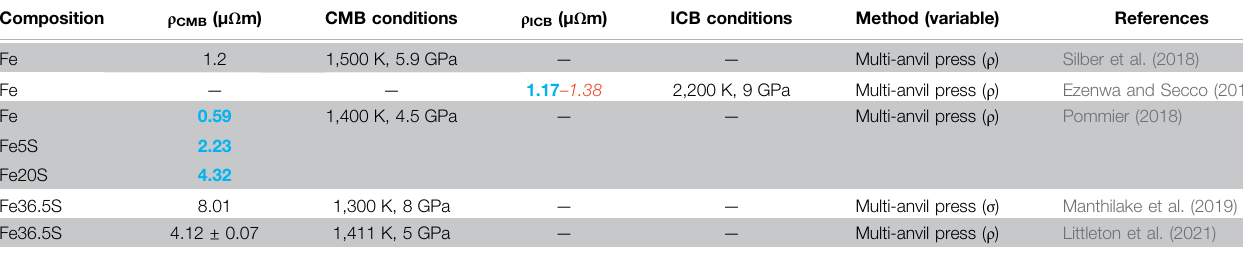
Values speci fi c to liquid Fe are in red, those speci fi c to solid Fe are in blue , while unspeci fi ed values are in black.